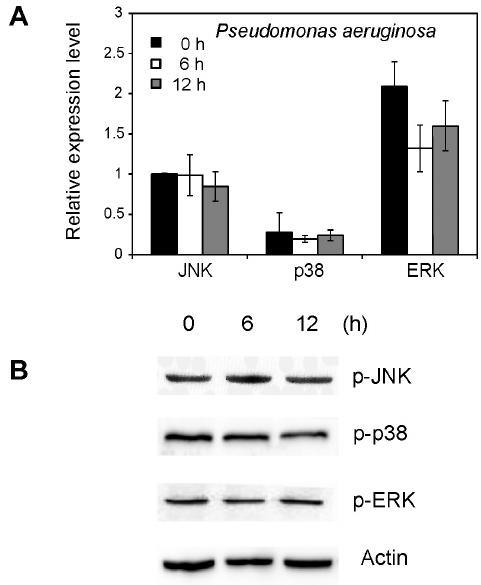
Figure 6. Effects of bacterial treatment on MAPK. ( A ) qRT-PCR analysis of JNK, p38 and ERK gene expression in whiteflies treated with bacterial for 0, 6 and 12 h; ( B ) Phosphorylation level of JNK, p38 and ERK in whiteflies analyzed by western blot. Each symbol and vertical bar represents the mean ± SD ( n = 3).